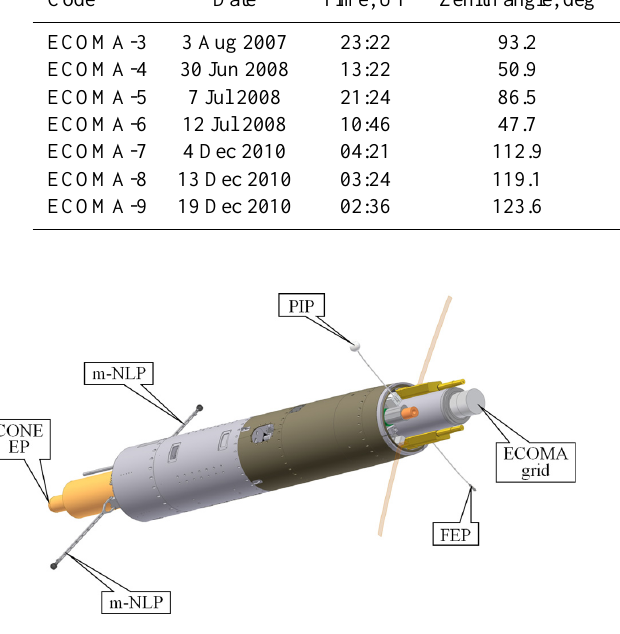
Fig. 1. ECOMA payload in-flight configuration after payload sep- aration at 70s. PIP: positive ion probe; FEP: forward electron probe (fixed-bias Langmuir probe); m-NLP: multi-needle Langmuir probe; CONE EP: electron probe as part of the CONE instrument (on upleg in the